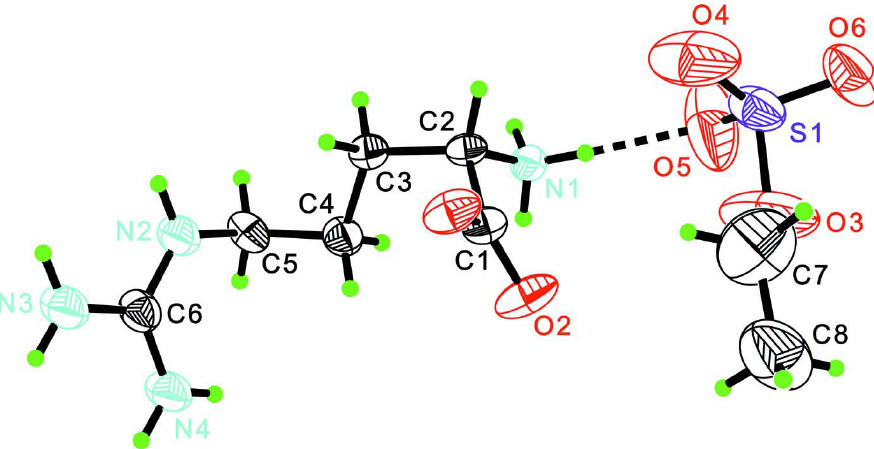
Figure 1 A perspective view of the asymmetric unit of (I) showing the atomic numbering and displacement ellipsoids at the 50% probability